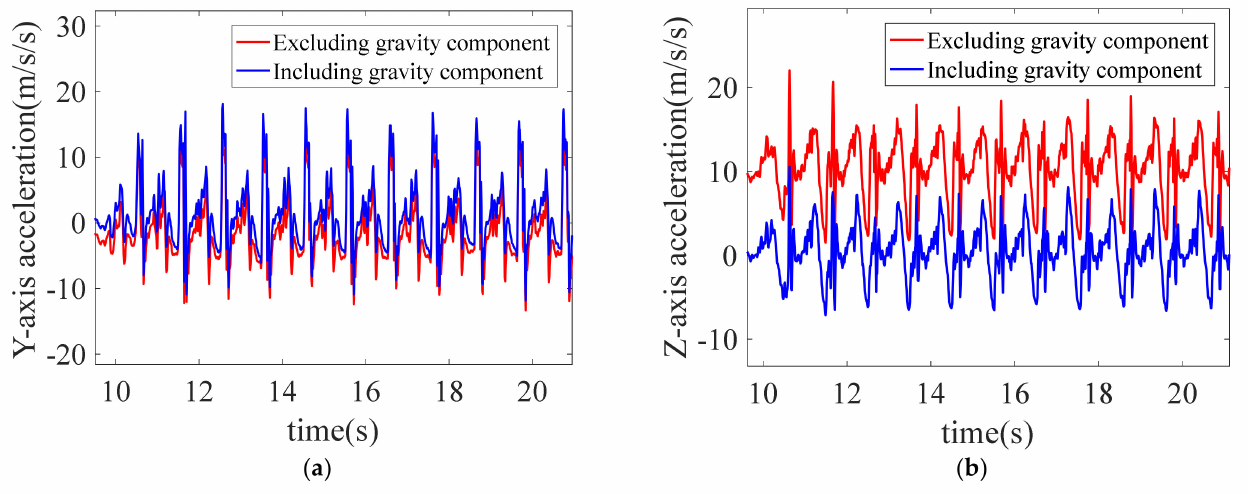
Figure 12. Comparison diagrams before and after deducting gravity component. ( a ) Y -axis accelera- tion before and after deducting gravity component; ( b ) Z -axis acceleration before and after deducting gravity